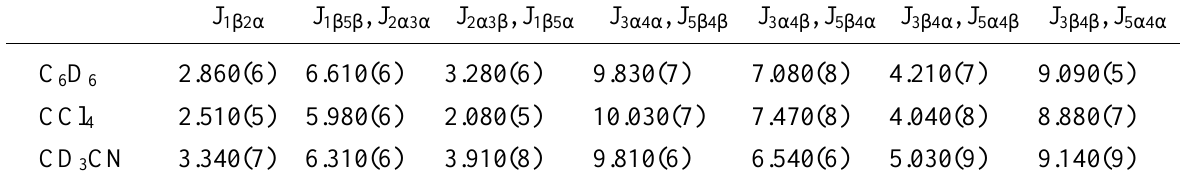
Table 1. Vicinal proton-proton coupling constants in trans-1,2-dichlorocyclopentane